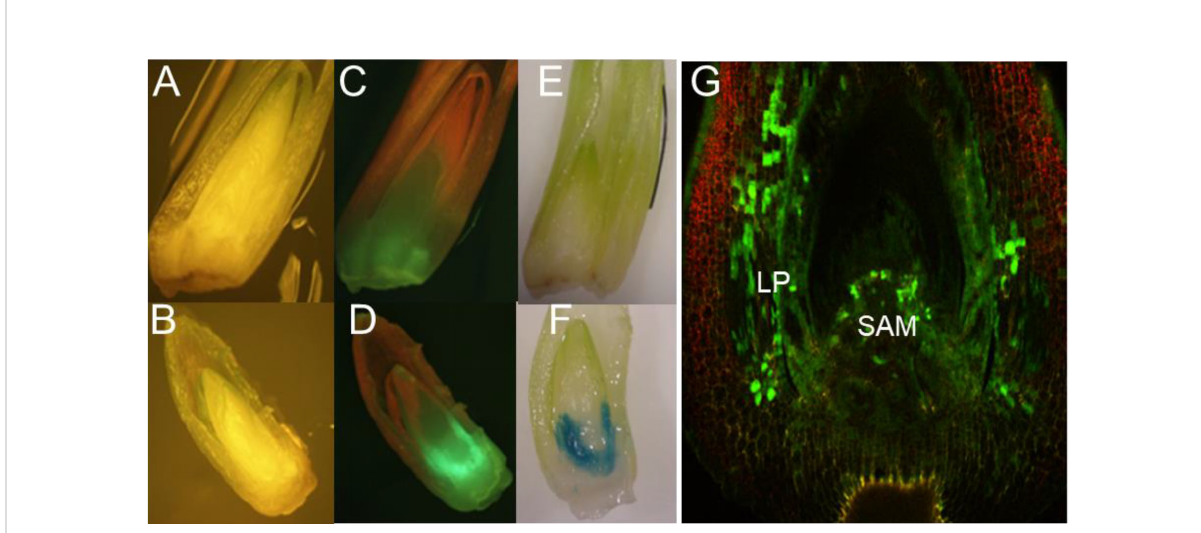
FIGURE 2 T-DNA delivery into relevant tissues of maize SEEs by centrifugation during inoculation. (A) Agrobacterium inoculation by centrifugation at 1 x g with visual light control for GFP; (B) Agrobacterium inoculation by centrifugation at 291 x g; (C) GFP expression after Agrobacterium inoculation by centrifugation at 1 x g; (D) GFP expression after Agrobacterium inoculation by centrifugation at 291 x g; (E) GUS expression after Agrobacterium inoculation by centrifugation at 1 x g; (F) GUS expression after Agrobacterium inoculation by centrifugation 291 x g; (G) Detailed view of GFP expression of a SEE inoculated by centrifugation in the presence of Agrobacterium , under a confocal microscope, LP-leaf primordia, SAM-shoot apical meristem. pMON42073 (Supplemental Figure S1) was used for these